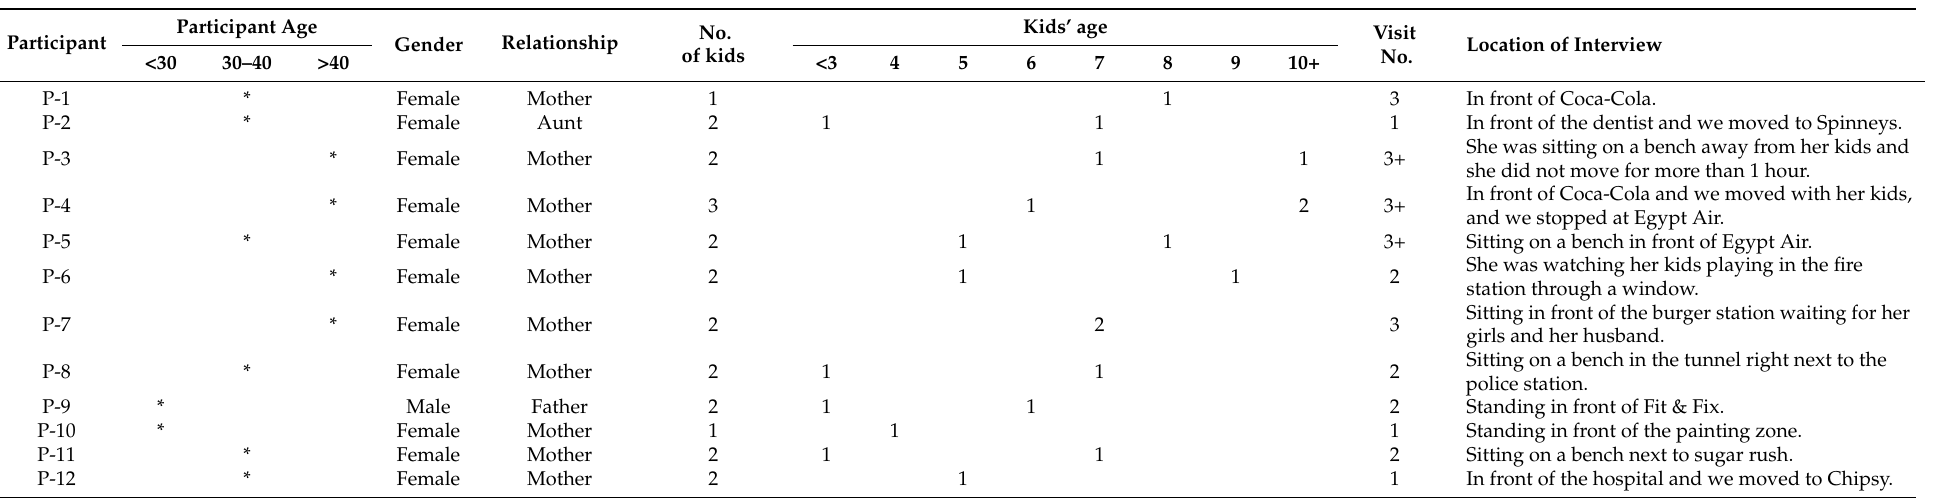
Table 1. The basic information of the involved